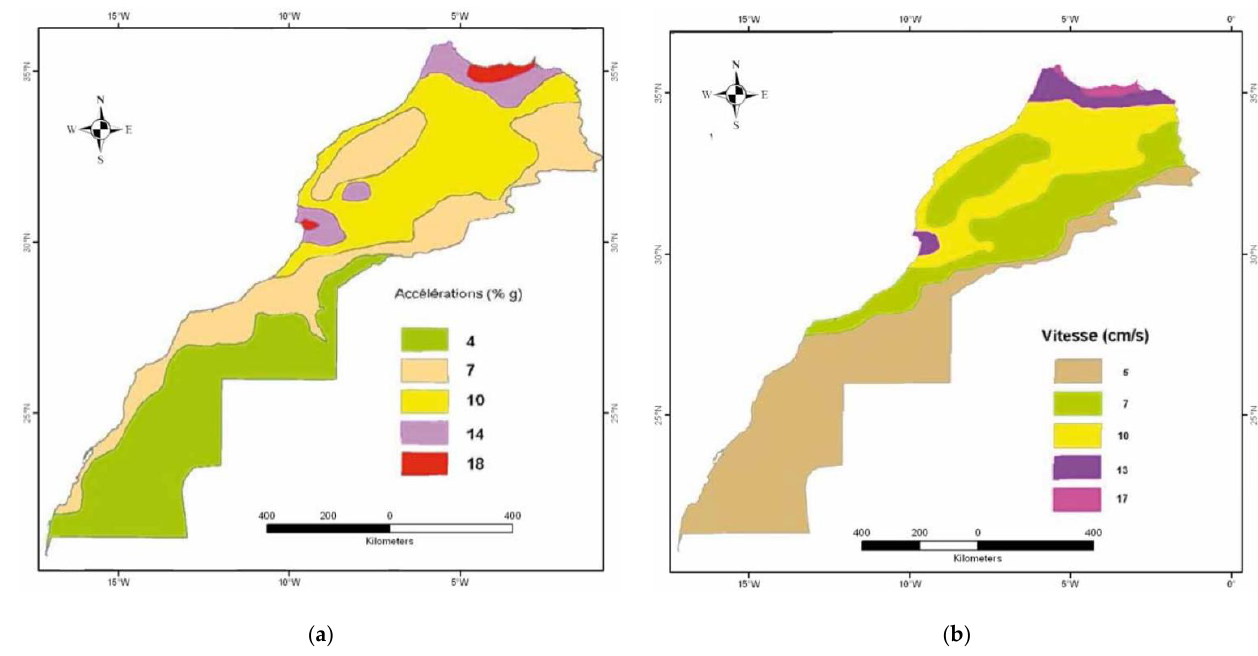
Figure 2. Seismic zoning in terms of ( a ) acceleration and velocity and ( b ) for probabilities of 10% in 50 years according to the national seismic code (RPS2000) [17]. Table 3. Ground types, according to Eurocode 8 [53] and the national seismic standard (RPS2000) Table 2. Seismic acceleration values based on the national seismic standard [17].